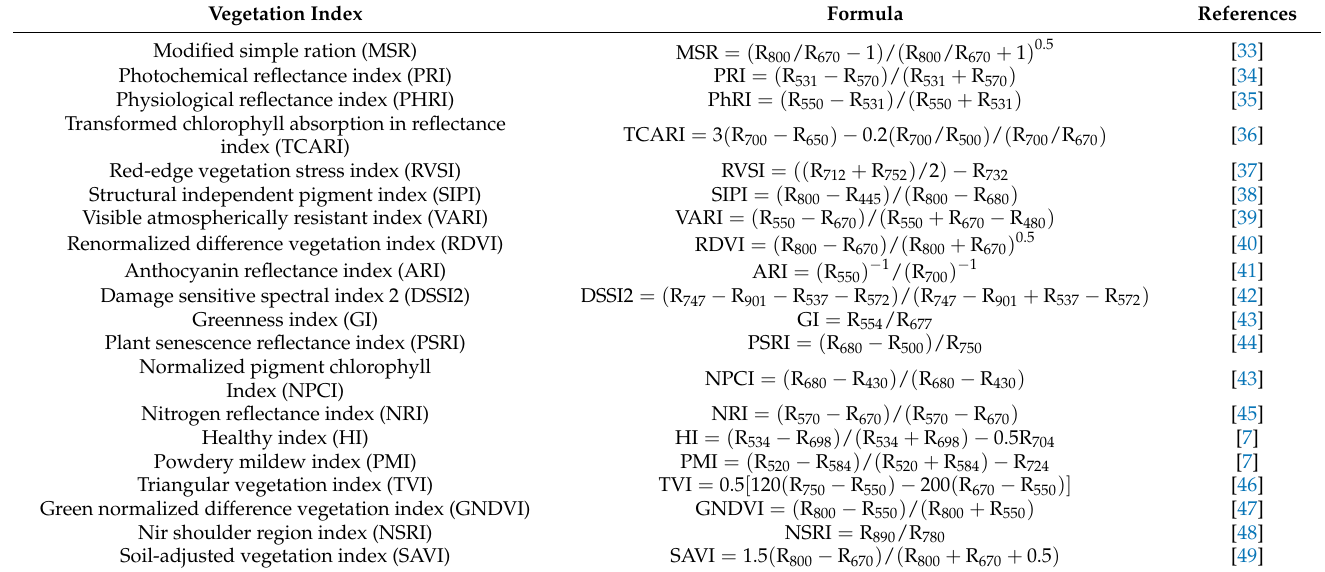
Table 1. Spectral vegetation indices.